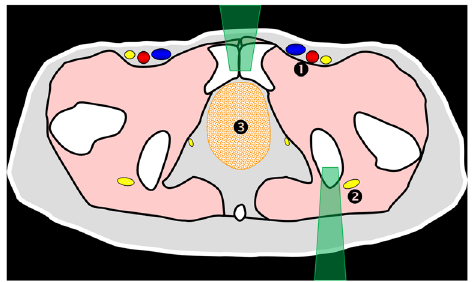
Fig. 18 Diagrammatic representation of the pelvis at the pubis symphysis level showing the principal structures to avoid ( 1 femoral vessels and nerve, 2 sciatic nerve, 3 visceral structures) and the safe approaches ( green areas )